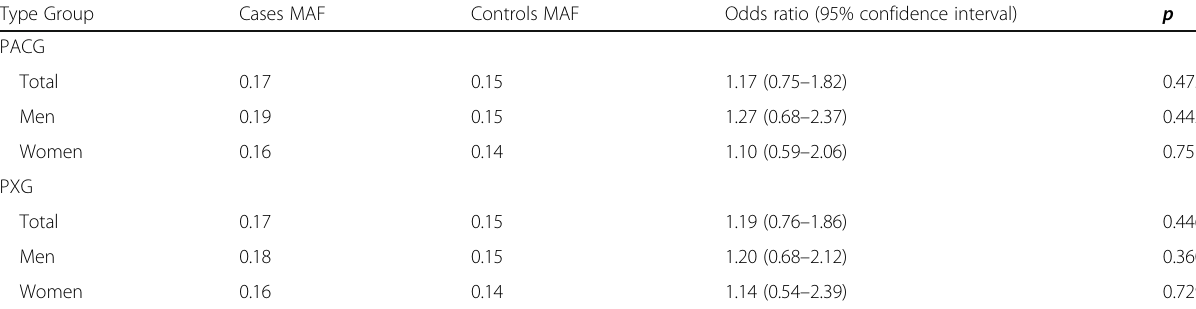
Table 2 Minor allele frequency of rs1043784[C] polymorphisms in cases and controls Type